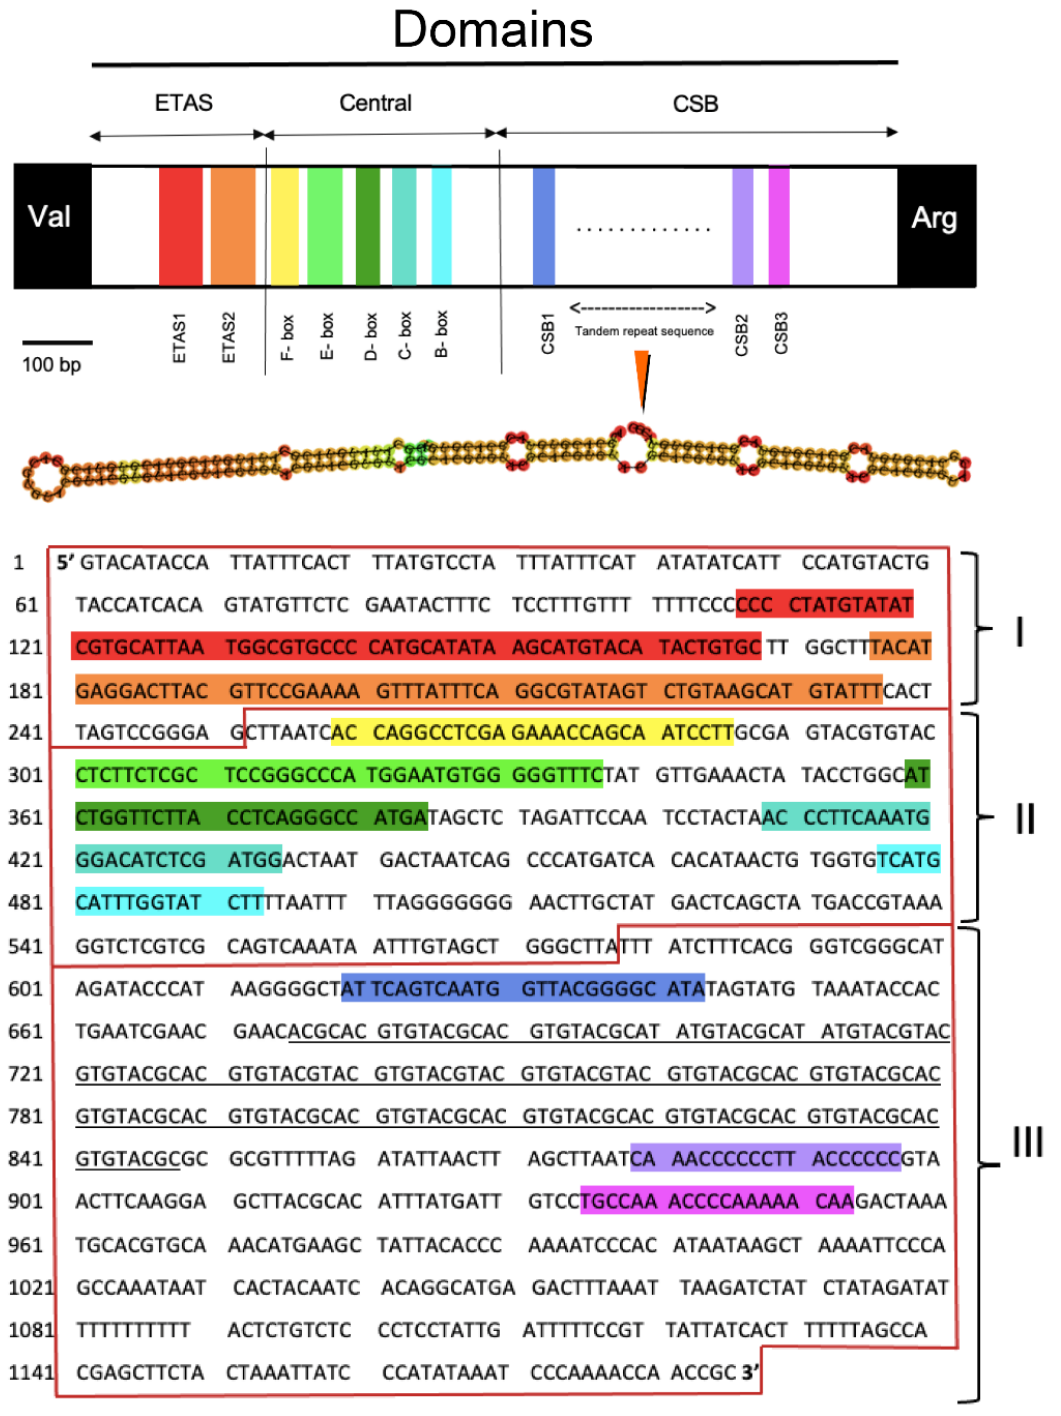
Figure 6. Visual representation of the D-loop/control region (CR) in the mitochondrial genome of the moon bear ( Ursus thibetanus) . The CR is divided into the extended terminal association sequence (ETAS), central, and conserved sequence block (CSB) domains. Locations of the ETAS 1 and ETAS 2, CSB1, CSB2, CSB3 blocks, as well as the large highly conserved regions within the central domain are shown. The long repetitive motif is underlined, and its secondary structure is depicted immediately below the visual representation of the CR. The CR of Ailuropoda melanoleuca , Manis javanica , and Eubalaena glacialis were similar. Nonetheless, no tandem repeat located after the CSB1 motif was observed in E. glacialis . Nucleotides are highlighted with different colors to match features in the graphical representation of the CR.